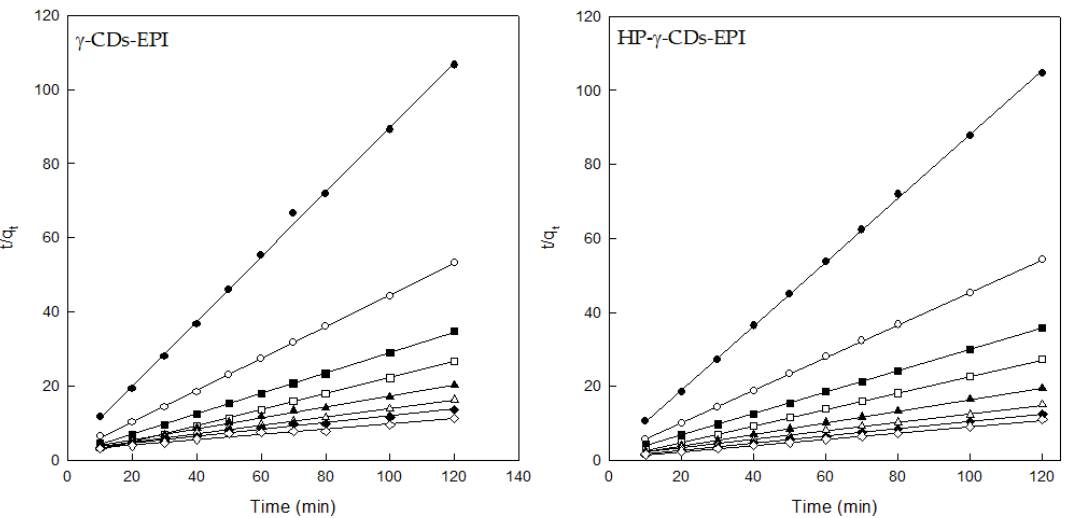
Figure 7. Pseudo-second order model analysis for both adsorbents and different DR concentrations (25 mg/L (●), 50 mg/L ( ○ ), 75 mg/L ( ■ ), 100 mg/L (□), 150 mg/L ( ▲ ), 200 mg/L (Δ), 250 mg/L ( ♦ ) and